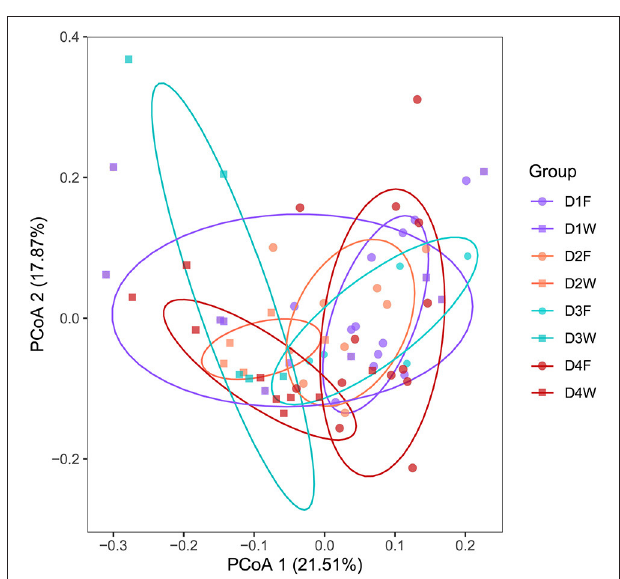
FIGURE 3 | Principal-coordinate analysis (PCoA) showing the bacterial community structures of fruiting body and wood from four decay classes.